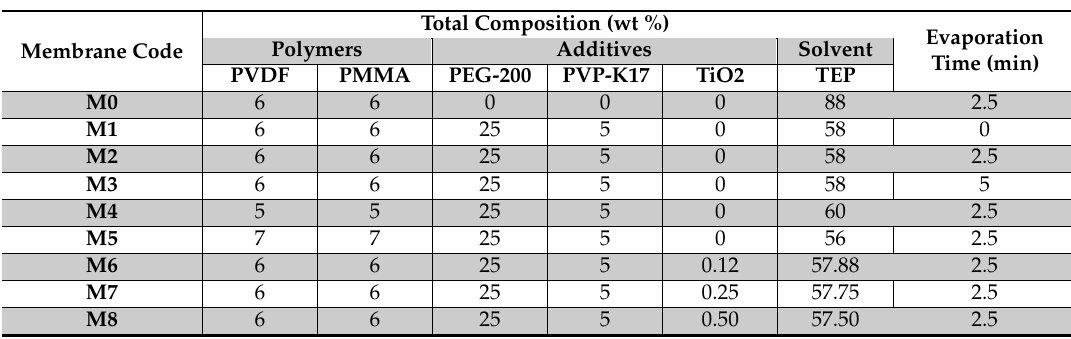
Table 6. Composition of membrane casting